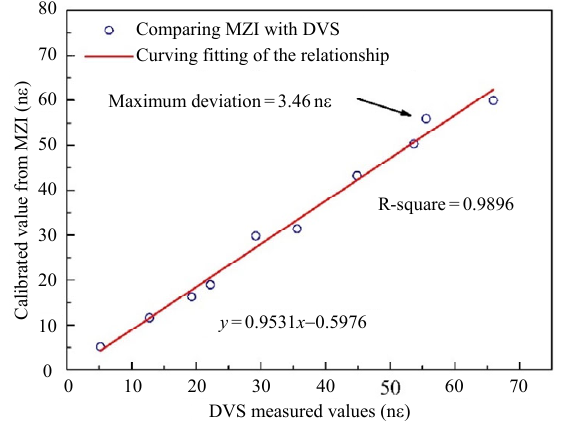
Fig. 12 Comparison between the variations sensing results of DVS and MZI.